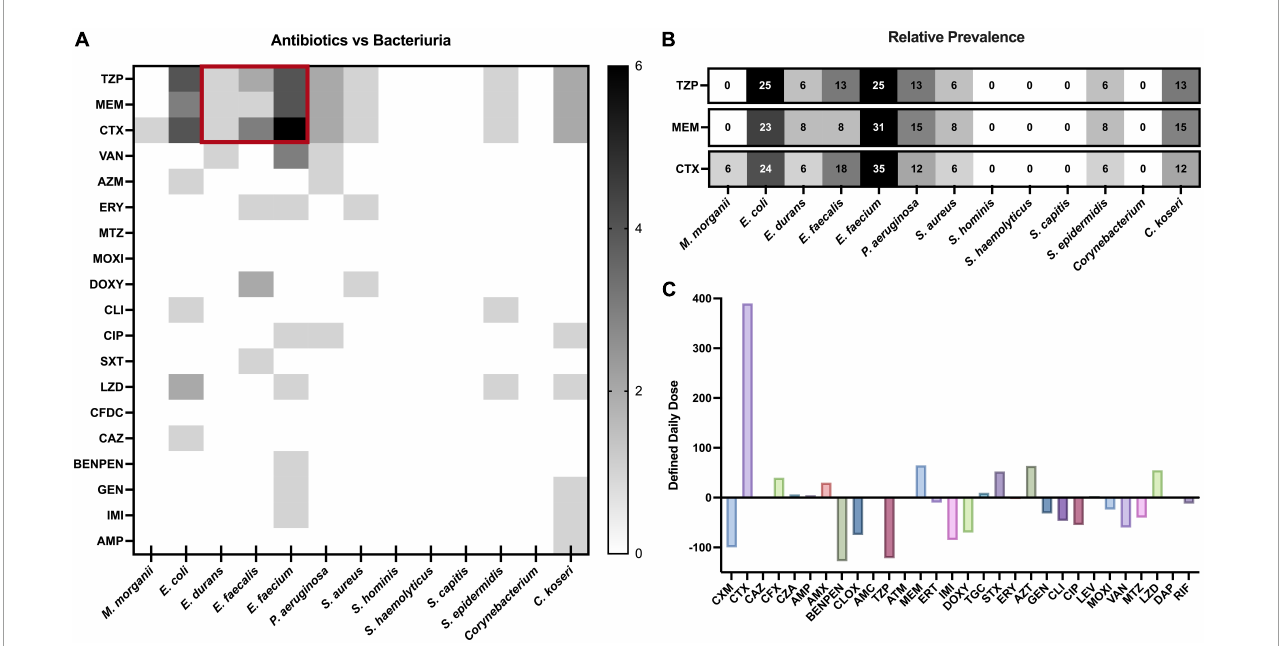
FIGURE5 Relationship between antibiotic use and bacteriuria. (A) Heatmap correlation between bacteriuria and antibiotic treatment illustrated in numbers. Abbreviations for antibiotics can be found in Supplementary Table 1 . (B) Correlation heatmap showing the proportion within a species that was exposed to a specific antibiotic. Analysis pool based on that the patient received at least one antibiotic (any) and was colonized by minimum one species (any). Numbers represent the percentage of isolates exposed to the given antibiotic (TZP/MEM/CTX). The percentage for any given antibiotic can be above 100% as isolates from different species were occasionally co-colonizing during the same treatment. (C) The difference in antibiotic prescription in the Uppsala ICU from 2019 to 2020 (pre-pandemic to pandemic) given in defined daily dose. Positive values indicate prescription increase while negative values indicate prescription